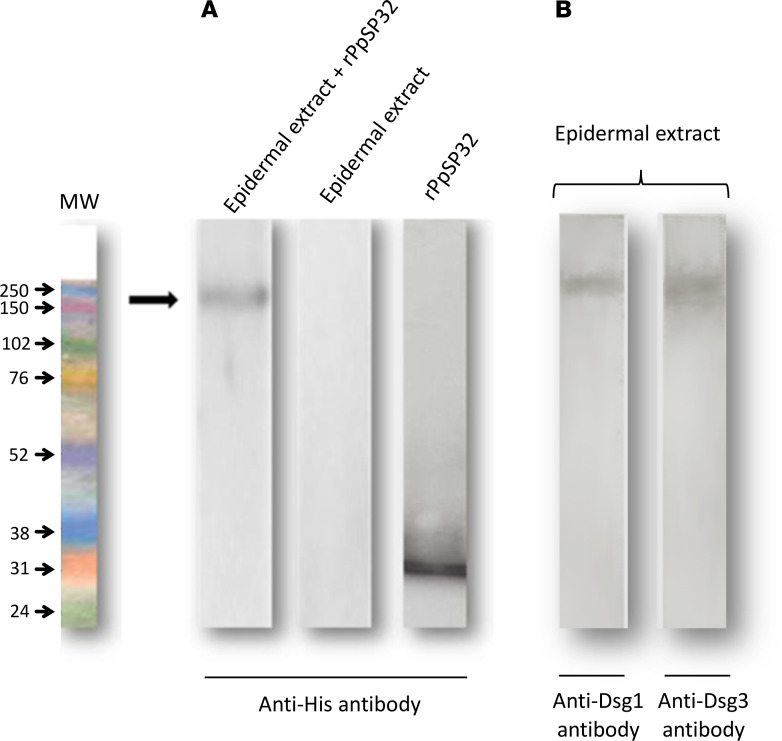
Binding of rPpSP32 to an epidermal protein of approximately 170 kDa demonstrated by a far-Western blot.The proteins of an epidermal extract were separated by PAGE. After being denatured and renatured, the proteins were either not incubated or incubated with the recombinant protein rPpSP32. (A) The putative interaction of rPpSP32 with 1 or more epidermal proteins was revealed using a peroxidase-labeled anti-His antibody. Controls correspond to the epidermal extract or the rPpSP32 His-tagged protein alone. The figure is representative of 3 independent experiments. (B) Dsg1 and Dsg3 were visualized in the epidermal extract using monoclonal anti-Dsg1 and -Dsg3 antibodies. MW marker, RPN 800E (Amersham), was used in this experiment.